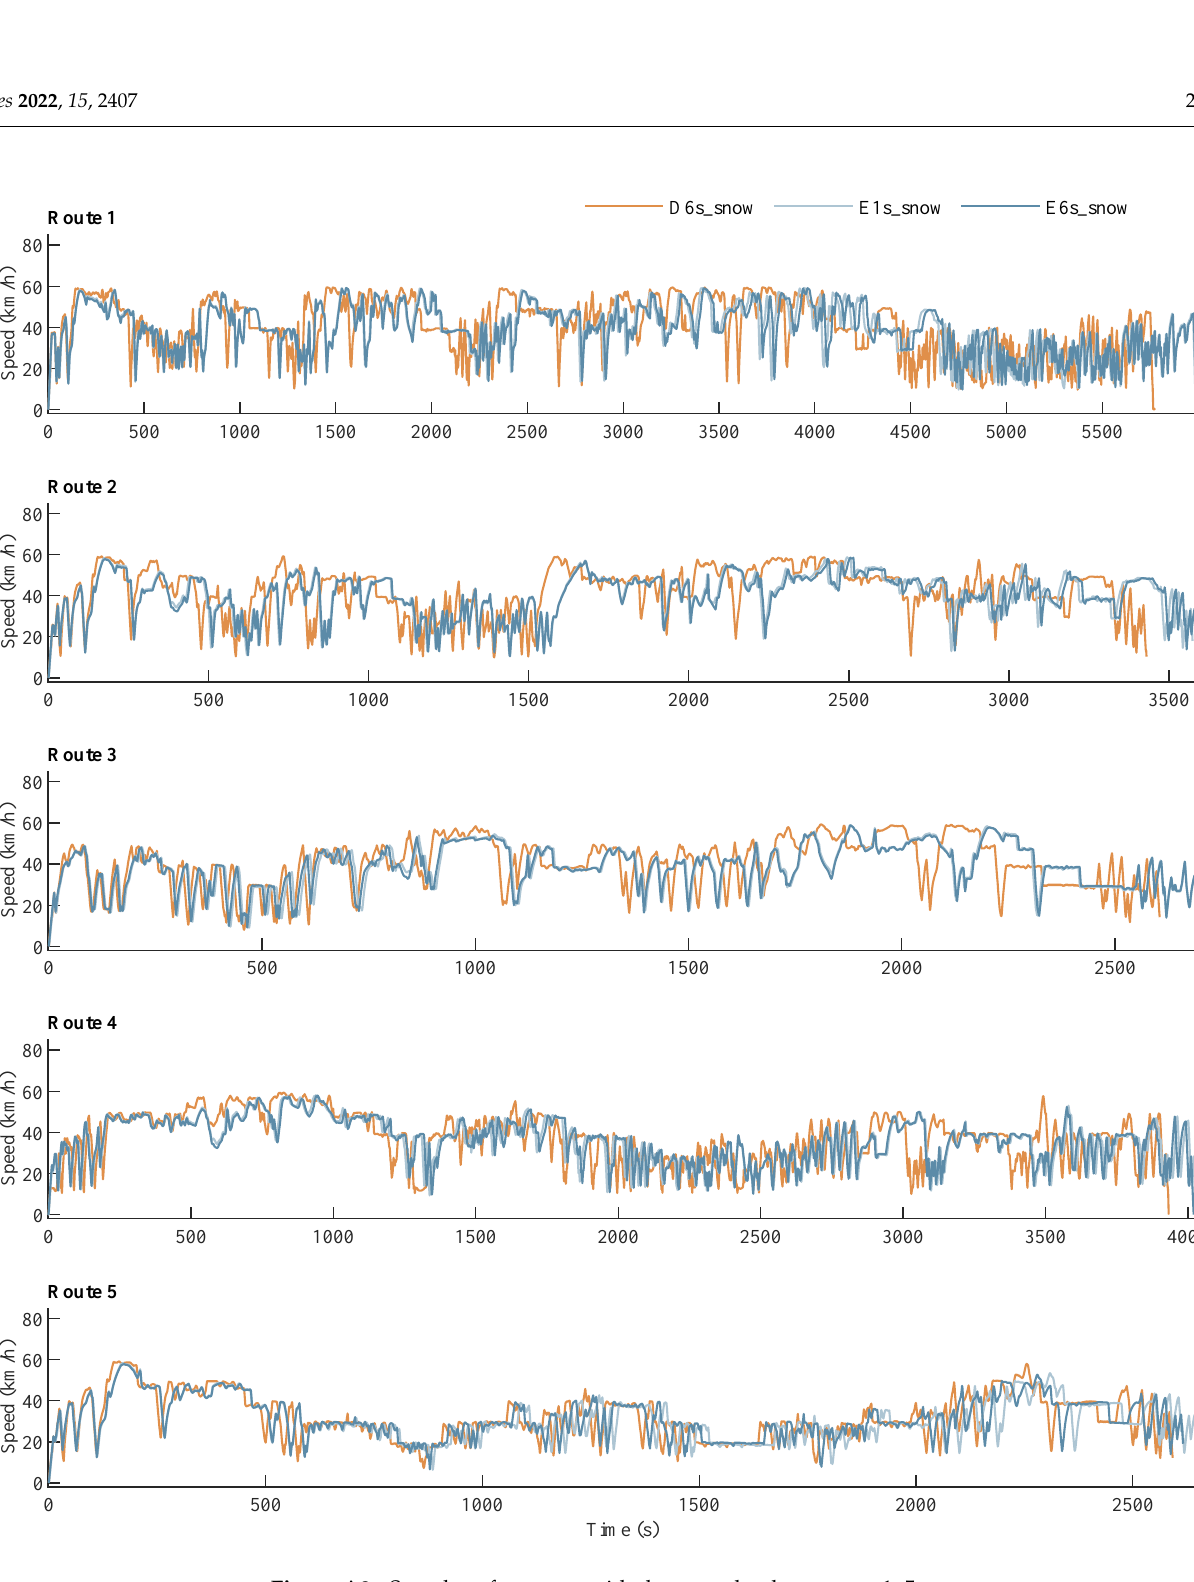
Figure A3. Speed performance with the snow load on routes